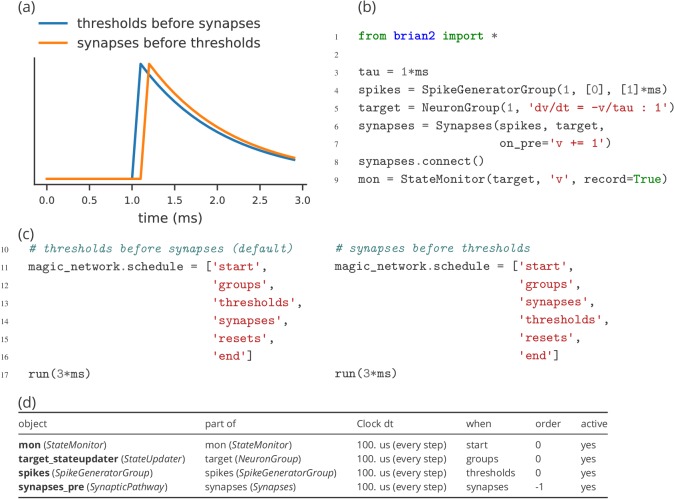
Demonstration of the effect of scheduling simulation elements.(a) Timing of synaptic effects on the post-synaptic cell for the two simulation schedules defined in (c). (b) Basic simulation code for the simulation results shown in (a). (c) Definition of a simulation schedule where threshold crossings trigger spikes and – assuming the absence of synaptic delays – their effect is applied directly within the same simulation time step (left; see blue line in (a)), and a schedule where synaptic effects are applied in the time step following a threshold crossing (right; see orange line in (a)). (d) Summary of the scheduling of the simulation elements following the default schedule (left code in (c)), as provided by Brian’s scheduling_summary function. Note that for increased readibility, the objects from (b) have been explicitly named to match the variable names. Without this change, the code in (b) leads to the use of standard names for the objects (spikegeneratorgroup, neurongroup, synapses, and statemonitor).